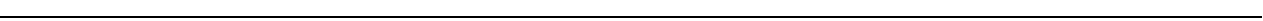
Fig. 5 MxB inhibits perinuclear association of HSV-1 capsids and nuclear translocation of viral genomes. a A549-GST and A549-MxB cells were infected with HSV-1 strain F in the presence of cycloheximide. Cells were fi xed at the indicated time points post infection. HSV-1 capsids were stained with anti-VP5 antibody and nuclei were stained with Hoechst 33342. Samples were analysed by confocal microscopy. Data represent the number of VP5-exposed dots per cell. Boxes depict median, 25th and 75th percentile with mean marked with a ‘ + ’ . Whiskers denote the 10th and 90th percentile. For each comparison, 166 cells were randomly selected. Kruskal – Wallis test with cell line and time as explanatory variables: cell line, χ 2 = 0.0033671, df = 1, p = 0.9537; time, χ 2 = 896.1, df = 3, p < 0.0001. Pairwise Wilcoxon's rank sum tests: NS p = 1.00. Data are representative of two independent experiments. Right panels show representative images. Scale bar, 10 µ m. b, c A549-GST and A549-MxB cells were mock-infected or infected with EdC-labelled HSV-1 strain F (puri fi ed by density gradient centrifugation, approx. 40 particles per cell) in the presence of cycloheximide and fi xed at the indicated time points post infection. Nuclei were stained with DAPI, capsids were stained with anti-HC antibody and free genome foci were visualised using click chemistry. Cells were analysed by confocal microscopy with z-series image acquisition and projection along the z -axis. Individual measurements with mean ± s.d. are shown. Data are representative of three independent experiments. For each comparison, 51 cells were randomly selected. Representative images show maximum projections. Scale bar, 10 μ m. b Percentage of capsids per cell coinciding with the nuclear mask. ANOVA modelling fraction of capsids on nucleus with cell line and time as explanatory variables: cell line, F (1,300) = 45.3, p < 0.0001; time, F (2,300) = 101.2, p < 0.0001; antagonising interaction, F (2,300) = 24.91, p < 0.0001. Multiple comparisons: NS p ≥ 0.05, *** p < 0.001 and **** p < 0.0001. c Number of HSV genomes per cell coinciding with the nuclear mask. Kruskal – Wallis test with cell line and time as explanatory variables: cell line, χ 2 = 23.054, df = 1, p < 0.0001; time, χ 2 = 45.162, df = 2, p < 0.0001, antagonising interaction, χ 2 = 81.936, df = 5, p < 0.0001. Pairwise Wilcoxon's rank sum tests: NS p ≥ 0.05; **** p <